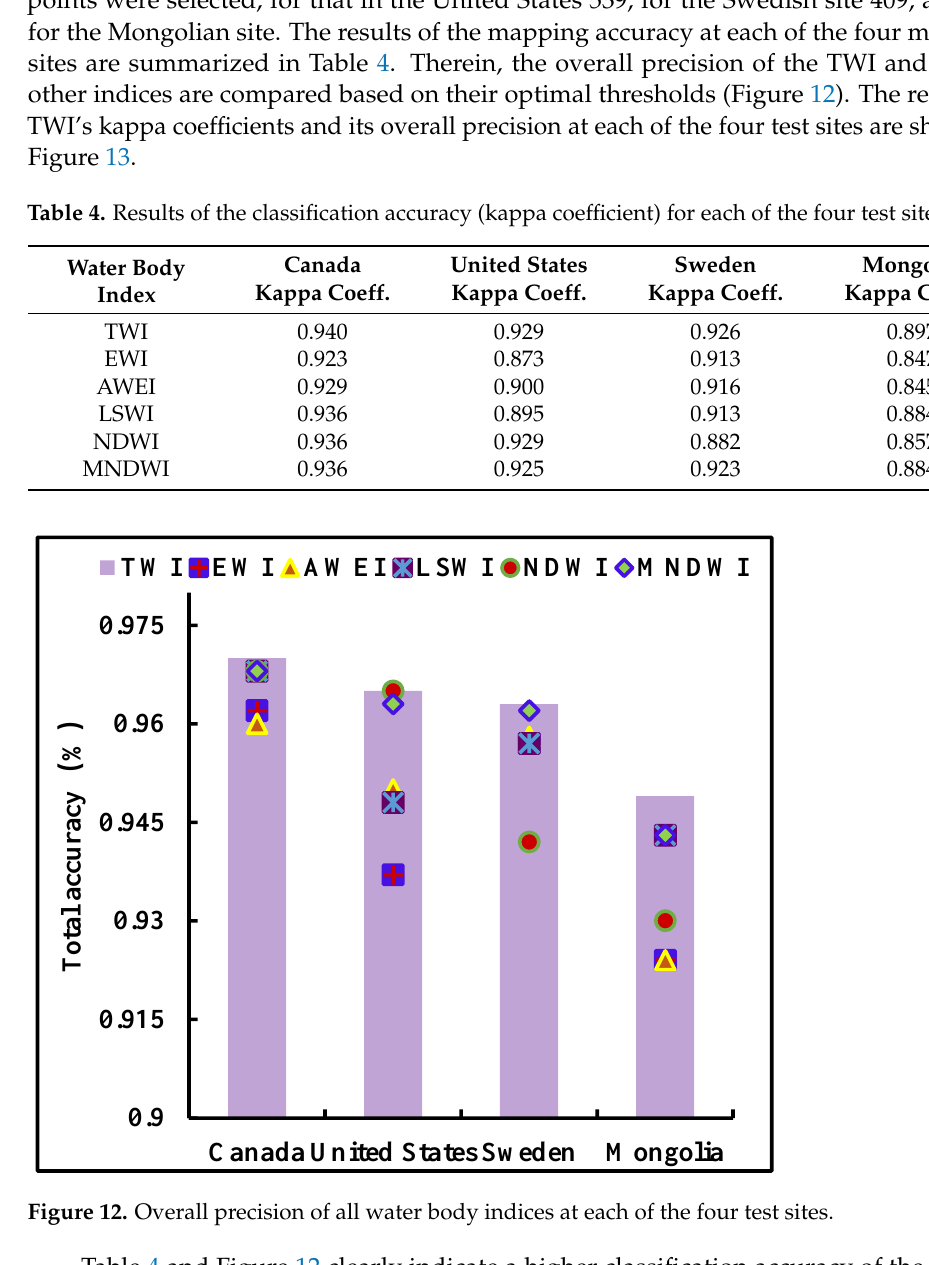
Figure 13. Results of TWI’s kappa coefficient and overall precision at each of the four test sites. Table 4 and Figure 12 clearly indicate a higher classification accuracy of the TWI as compared to the classification methods of the EWI, EWI, AWEI, LSWI, and MNDWI indices at all test sites. At the test sites in the United States, the accuracy rates extracted by the TWI and NDWI methods were almost the same, but the accuracy of the NDWI was lower than that of the TWI at the other test sites. The overall accuracy of the TWI was about 97% (Figure 12) at the Canadian and the United States sites. The overall precisions of the NDWI, MNDWI, LSWI, EWI, and AWEI methods at both sites were about 94% to 96%. Thus, the kappa coefficients of the TWI were superior to those of the other water body indices at the Canadian and the United States sites (Table 4), and thus the TWI